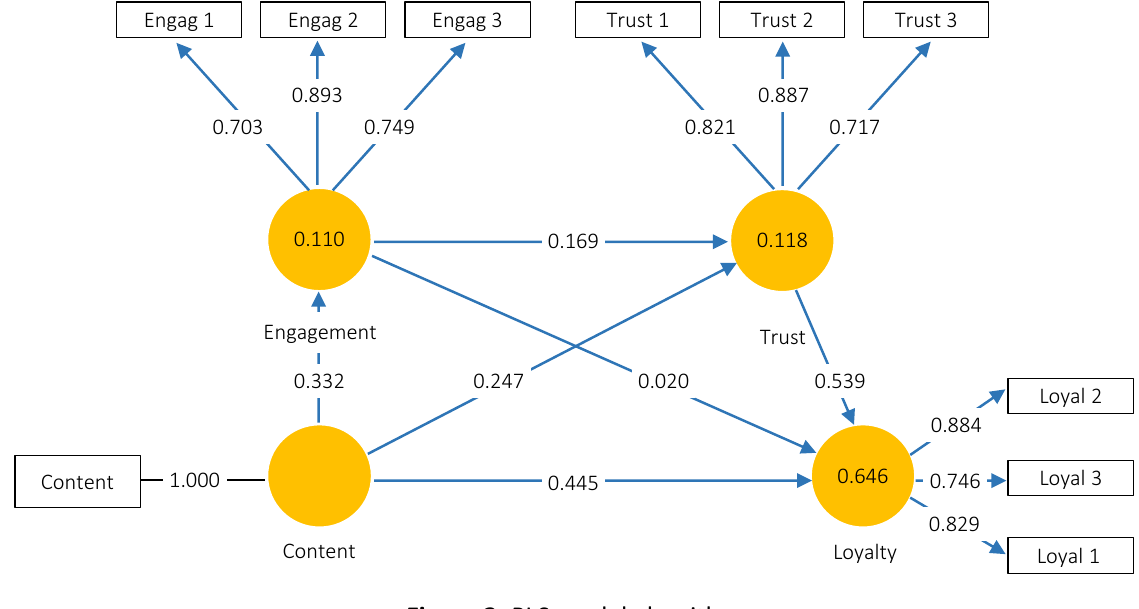
Figure 2. PLS model